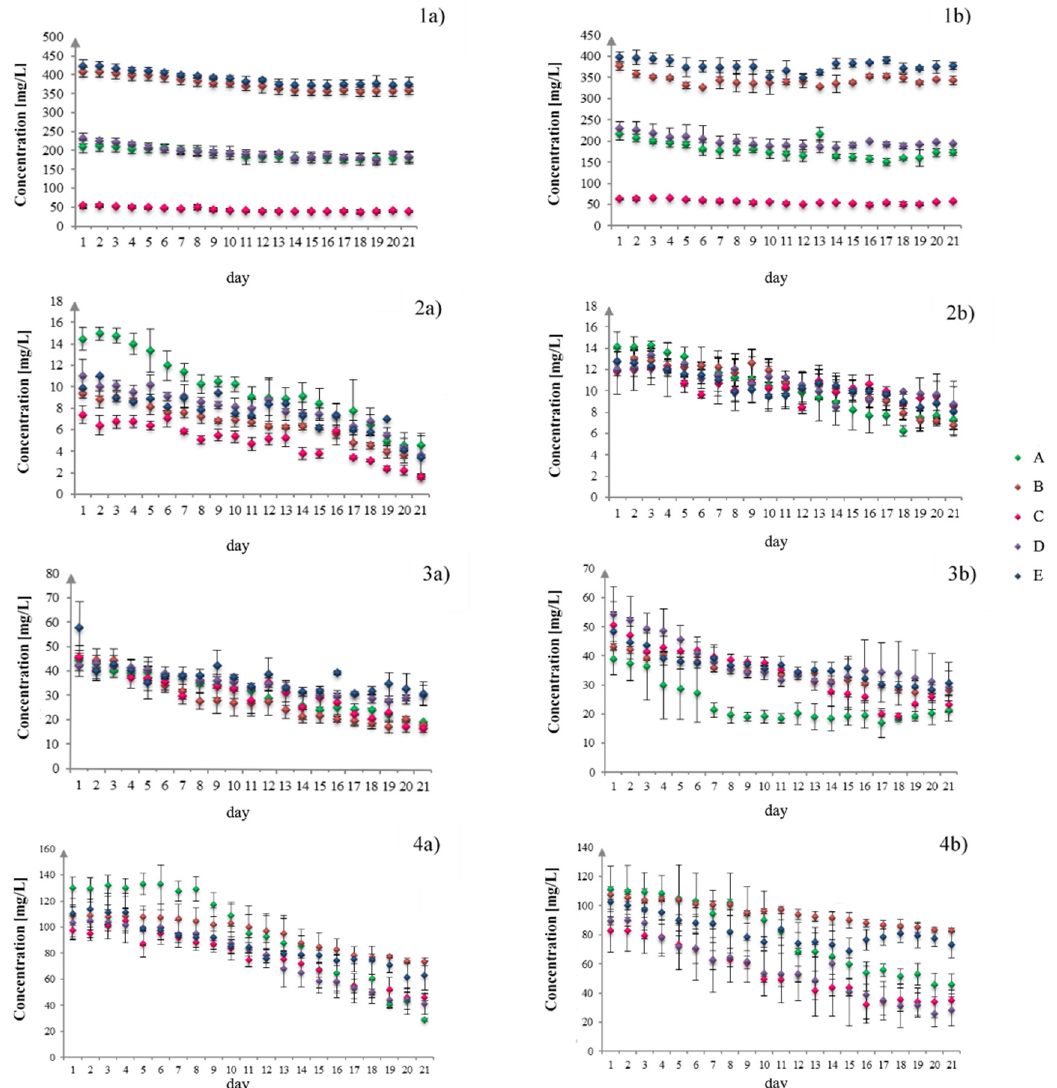
Figure 2. Changes in Mg(1), Zn(2), Cu(3), and Fe(4) concentration in A. bisporus in vitro culture medium as a function of time; ( a ) indirect sampling and ( b ) direct sampling (A, B, C, D, E—symbol identify in vitro culture—according to Table 2).